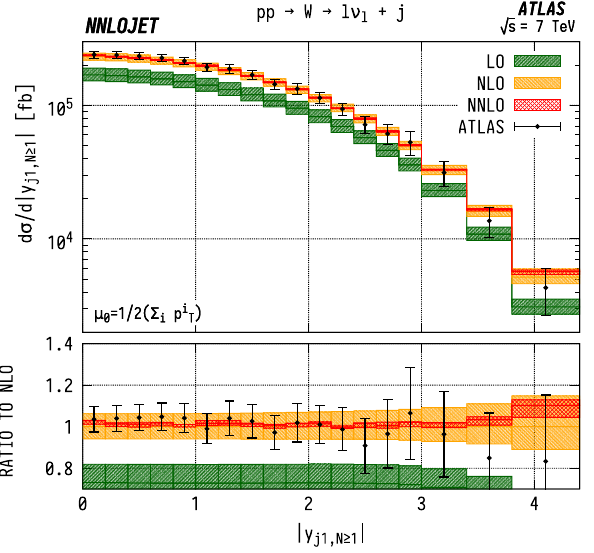
Fig. 23 ZJ cross section differential in the absolute rapidity | y j | of the leading jet. See Fig. 15 for